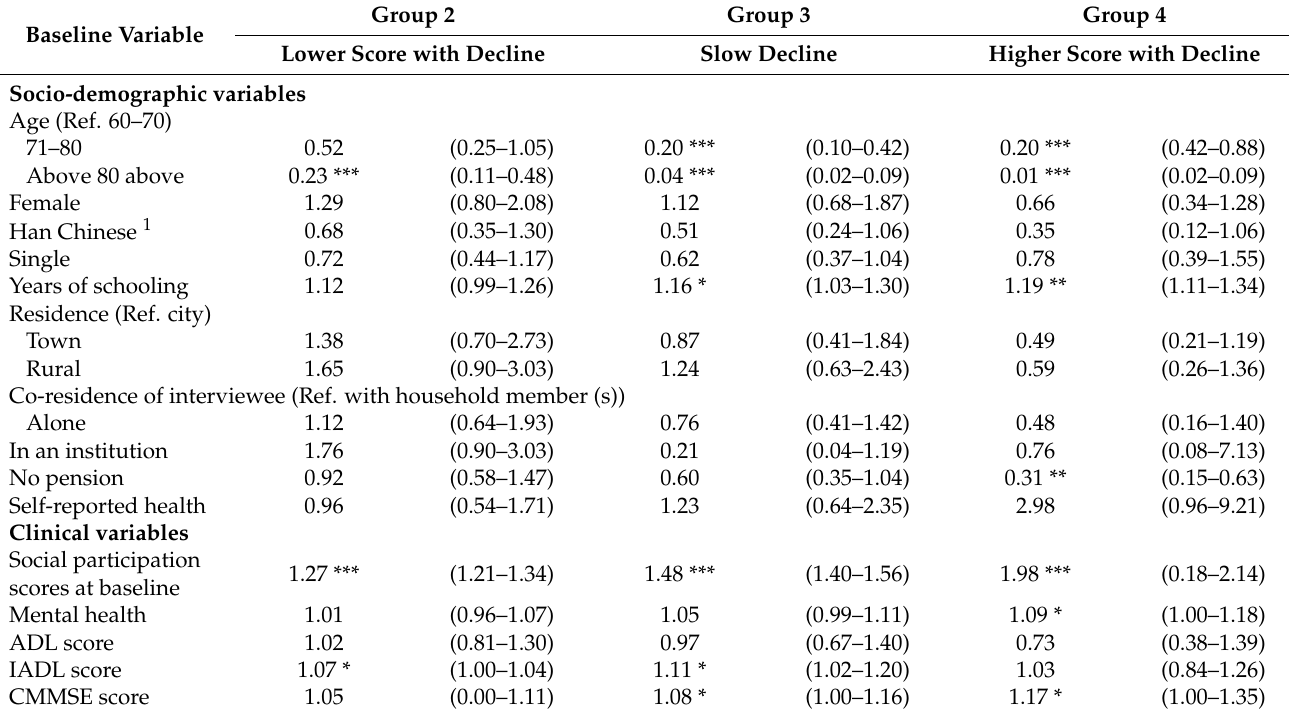
Table 3. Risk factors of trajectories (relative risk ratios and 95% confidence